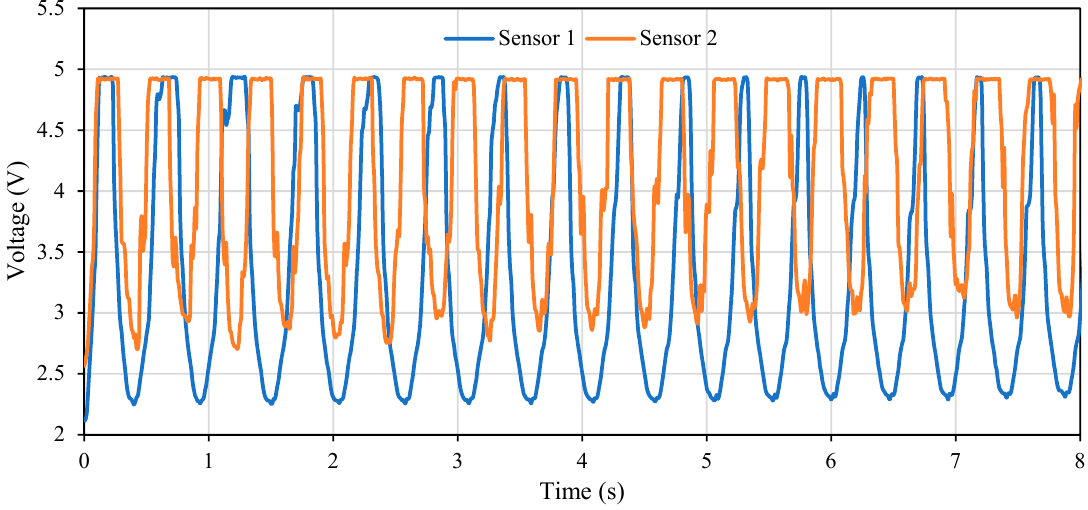
Figure 13. The output voltage of the two sensors with identical design over time when placed on the simulator under a volume strain of 17.3% and 58.2 BPM simulated by the respiratory simulator.